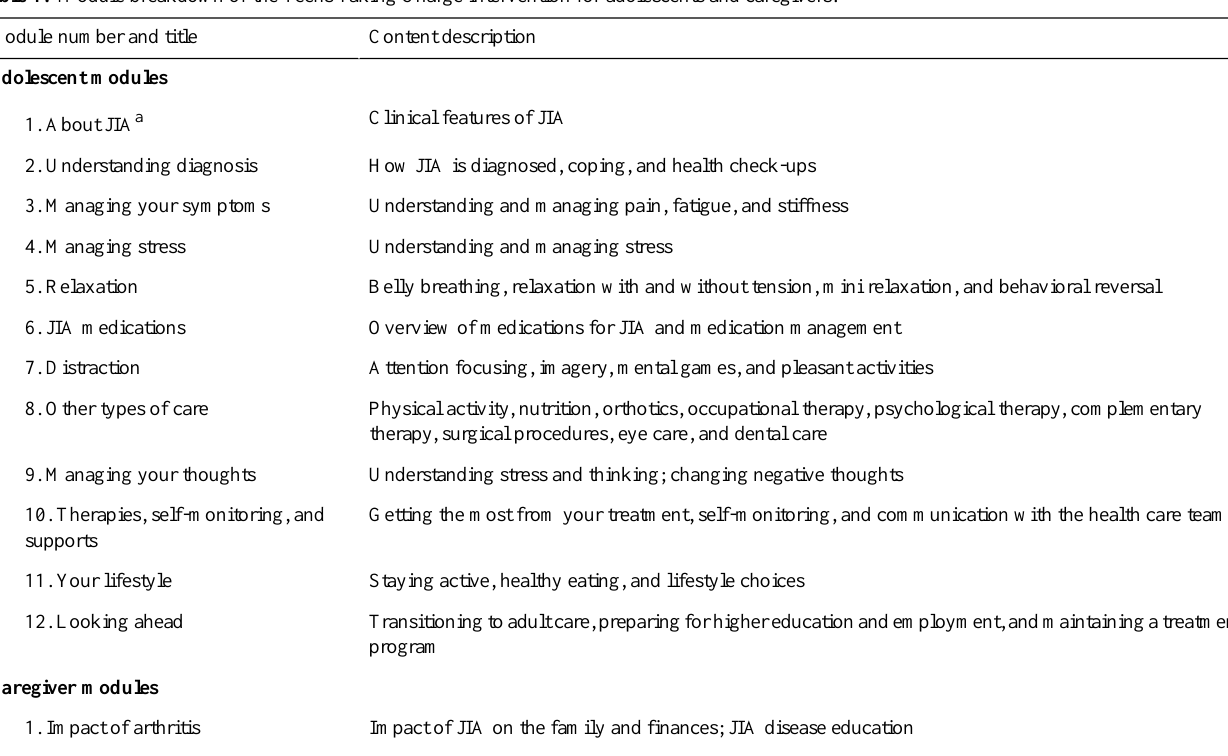
Table 1. Module breakdown of the Teens Taking Charge intervention for adolescents and caregivers.